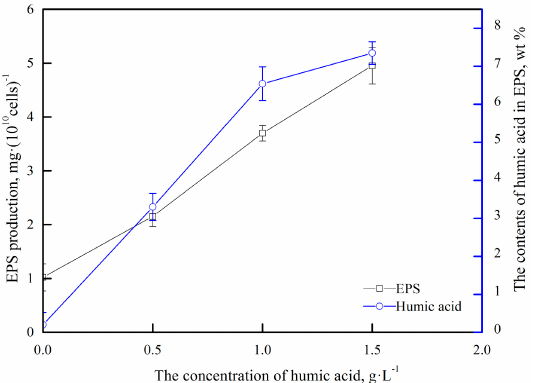
Figure 5. Trend in EPS and humic-acid contents in EPS for different humic-acid concentrations.